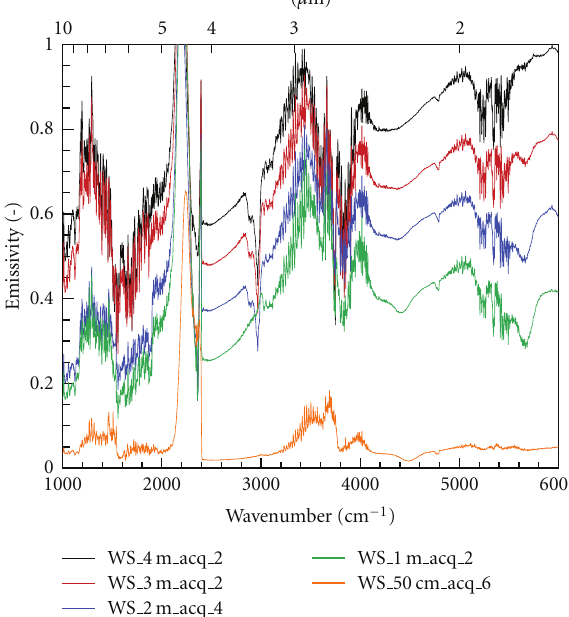
Figure 4: Maximum emission spectra from WS fuel beds with a length varying from 0.5 to 4m. The fuel bed load is 1kg/m 2 . Typical blackbody emission curves are plotted for the comparison.